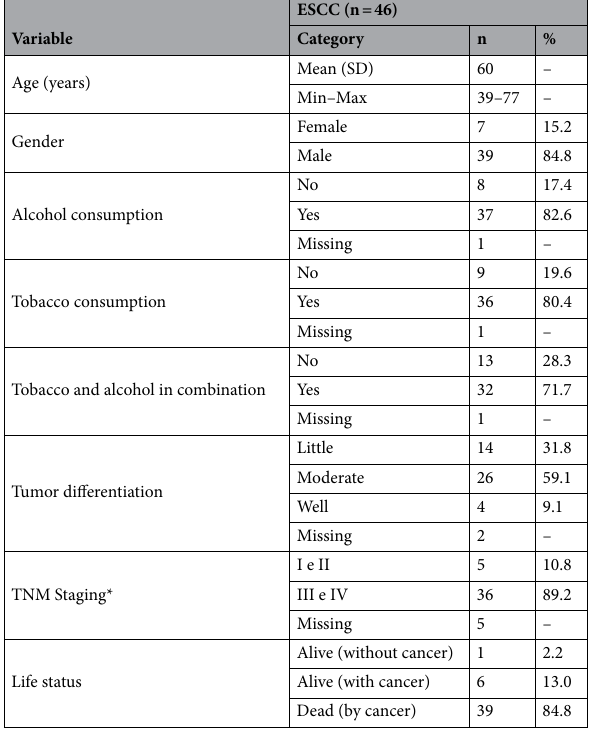
Table 1. Clinical-pathological features of esophageal squamous cell carcinoma patients. *TNM 7 edition staging. n number of cases, ESCC esophageal squamous cell